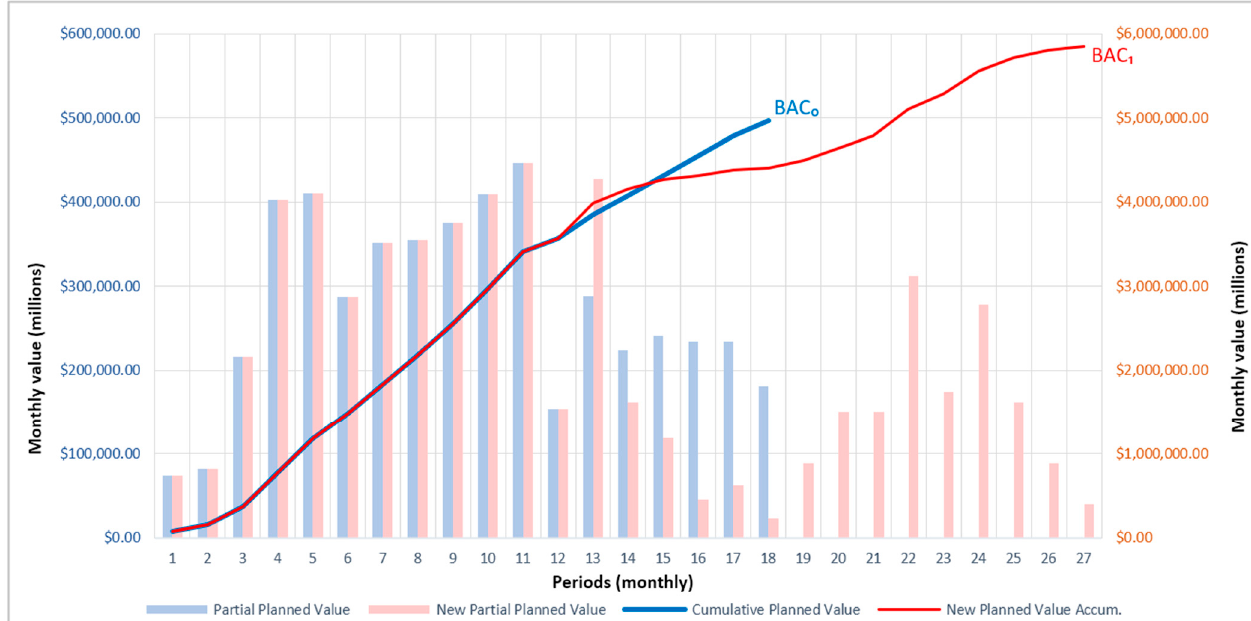
Figure 2. Original and final planned S-curve: Project 001 (source: Proaño-Narváez).